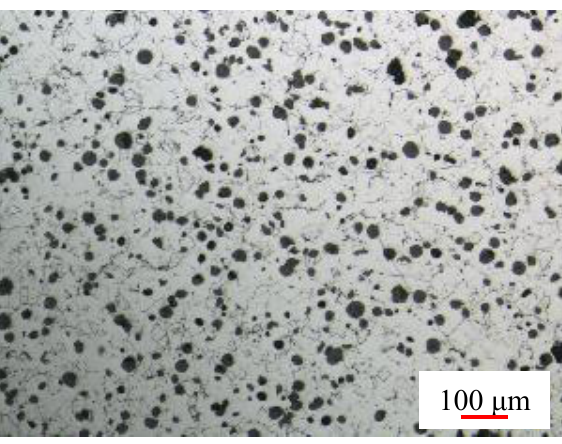
Figure 8. Micrograph of specimen taken from round bar shaped cast sample, etched with Nital 5%.